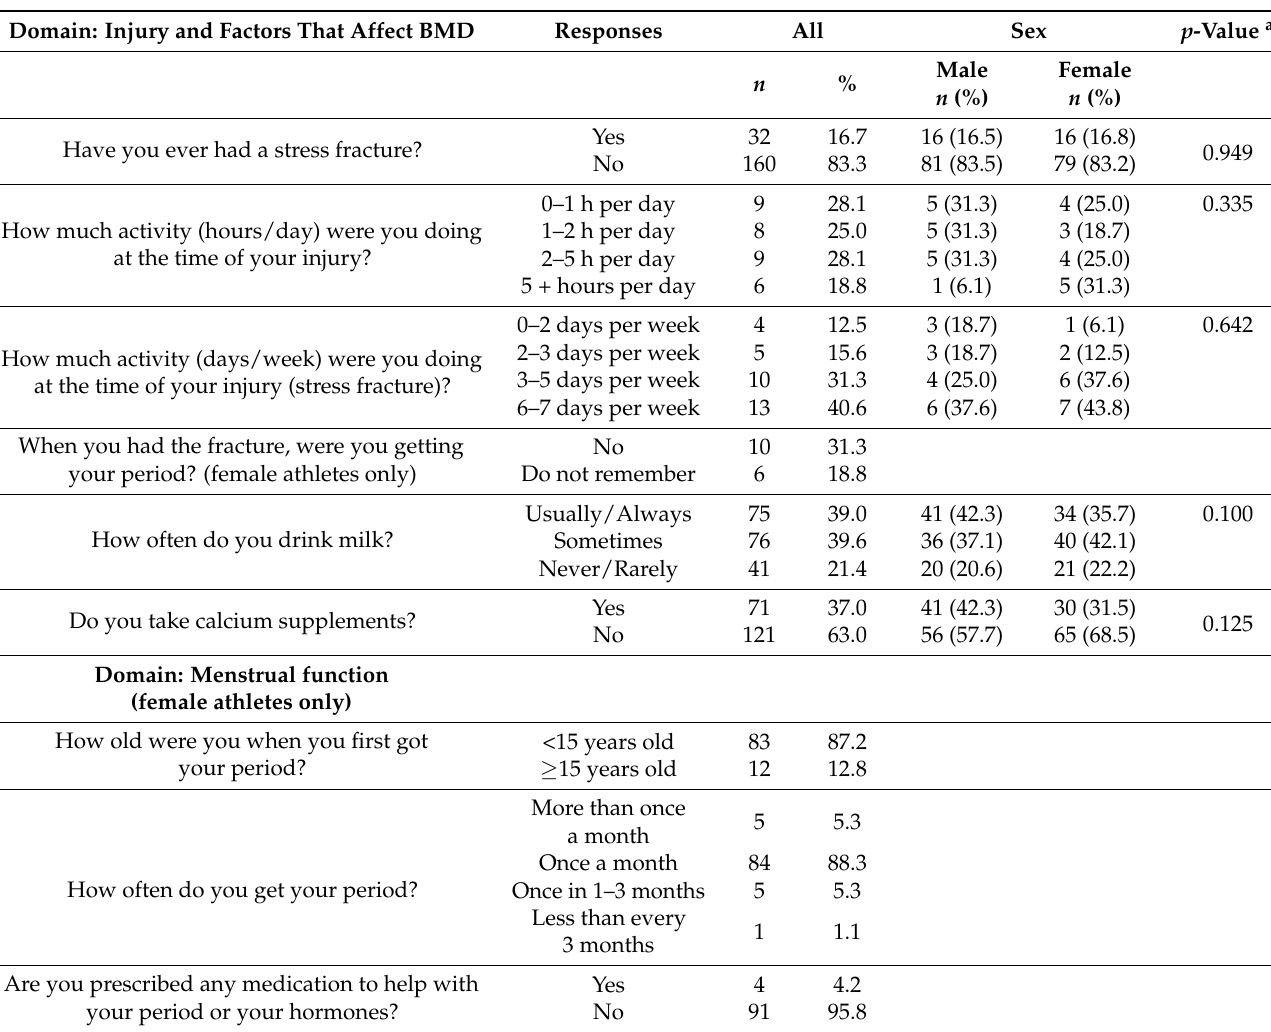
Table 4. Responses on injury and factors influencing BMD and menstrual function